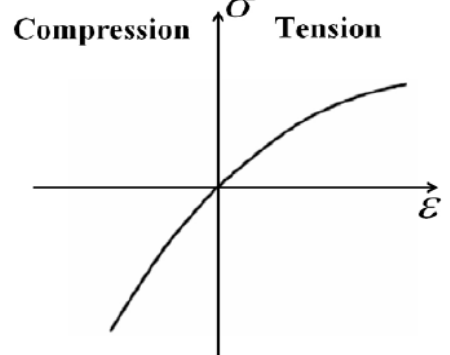
Figure 3. The nonlinear relationship between stress σ and strain ε